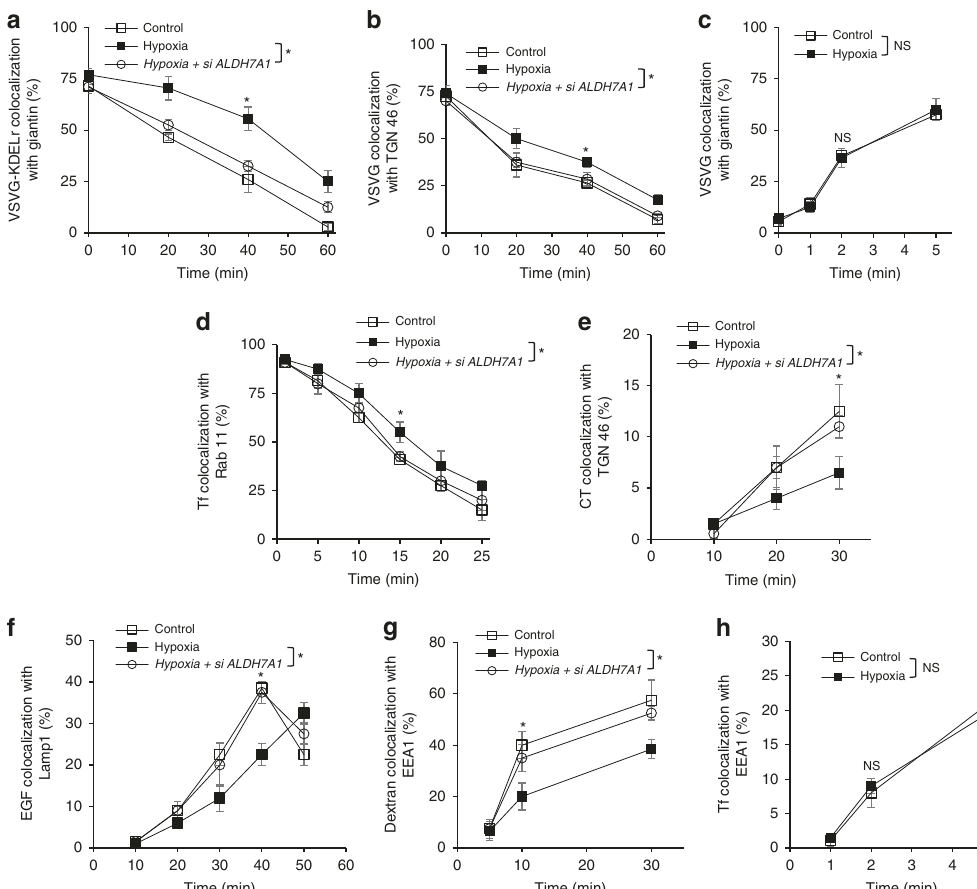
Fig. 5 Hypoxia inhibits the identical pathways targeted by ALDH7A1. Quantitative results are shown as mean with standard deviation; * p < 0.05, NS not signi fi cant, paired two-tailed Student ’ s t -test; n = 3 independent experiments. Source data are provided as a Source Data fi le. HeLa cells were assessed for the following transport pathways: a COPI transport from the Golgi to the ER was assessed through the quantitative colocalization of VSVG-KDELR with a cis -Golgi marker (giantin). b Transport of VSVG from the Golgi to the plasma membrane was assessed through the quantitative colocalization of VSVG with a TGN marker (TGN46). c Transport of VSVG from the ER to the Golgi was assessed through the quantitative colocalization of VSVG with a cis -Golgi marker (giantin). d Endocytic recycling of Tf from the recycling endosome (RE) to the plasma membrane was assessed through the quantitative colocalization of internalized Tf with a recycling endosome marker (Rab11). e Endocytic transport of CT to the Golgi was assessed through the quantitative colocalization of internalized CT with a TGN marker (TGN46). f Endocytic transport of internalized EGFR to the lysosome was assessed through the quantitative colocalization of internalized EGF with a lysosome marker (Lamp1). g Fluid-phase endocytosis of dextran was assessed through